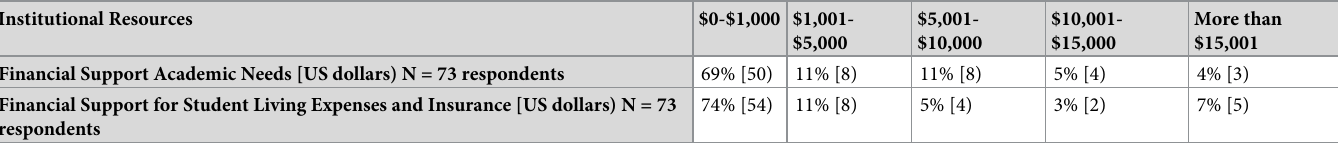
Table 1. Financial resource allocation for students denied accommodations on Step